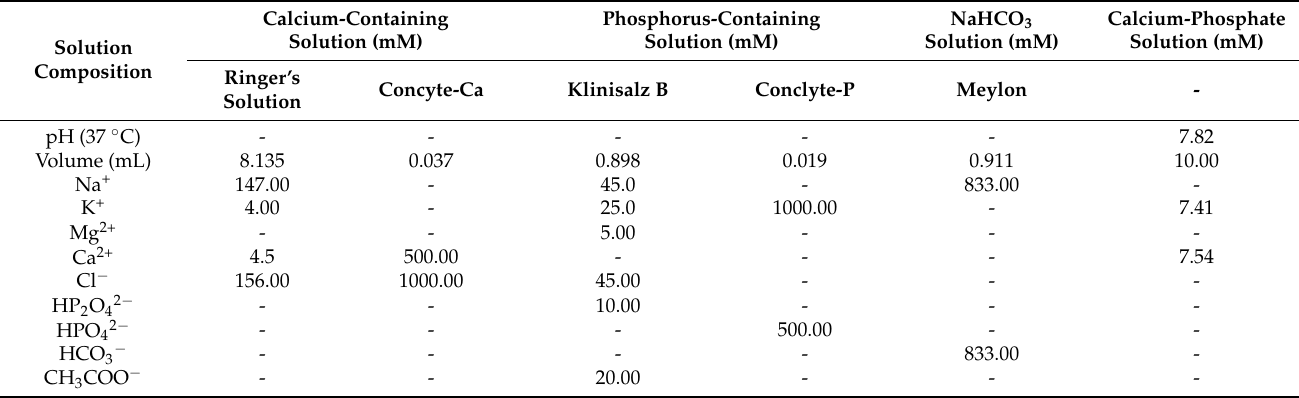
Table 1. Compositions of medical infusion preparations used for the preparation of supersaturated calcium phosphate solution.